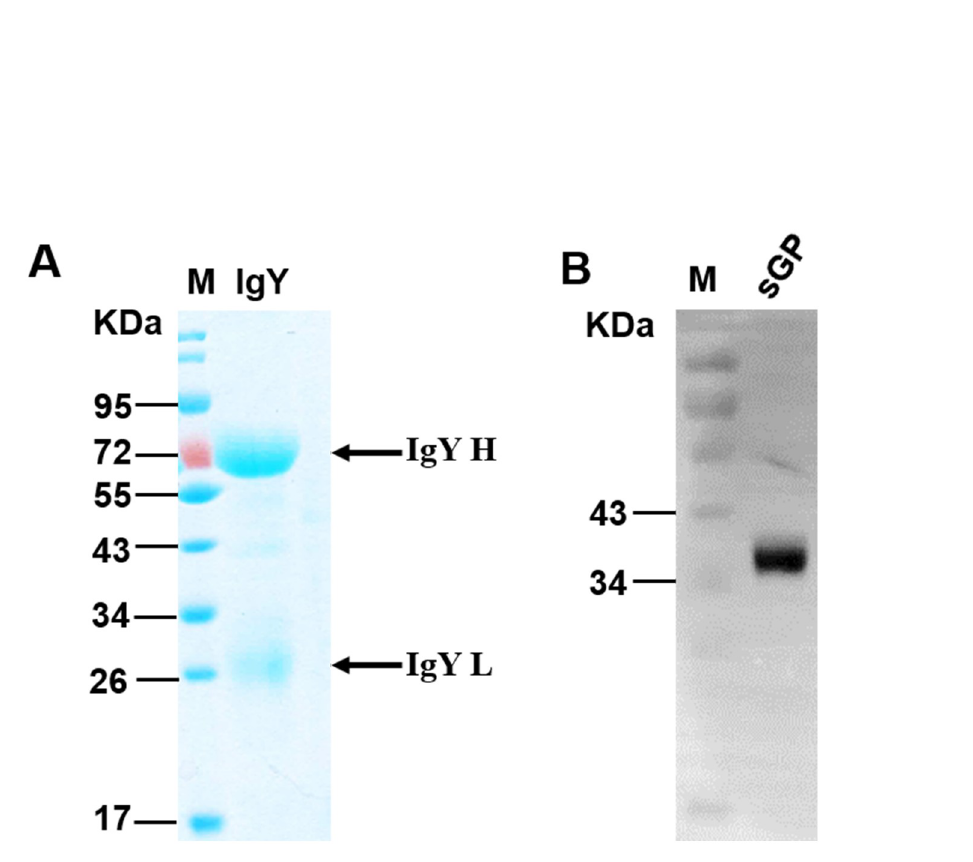
Fig 3. Purity and immunogenicity analysis of anti-EBOV IgY antibody. (A) Purified IgY isolated from the VSV Δ G/ EBOVGP vaccination group was analysed by SDS-PAGE. (B) Recombinant sGP expressed in E . coli was analysed by Western blot with anti-EBOV IgY. Recombinant sGP protein isolated by SDS-PAGE was incubated with EBOV specific IgY, then specific binding bands of sGP were detected by HRP-conjugated mouse anti-IgY mAb.